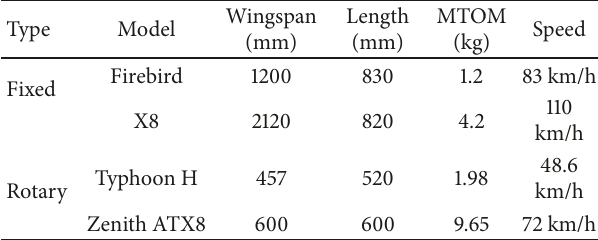
Table 4: UAV parameters for ground impact analysis.